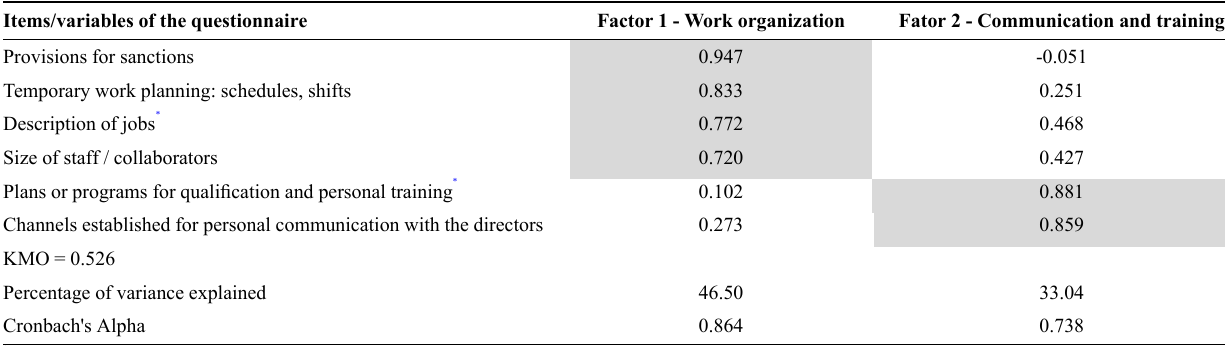
Table 4 - Key components analysis: Human Resources